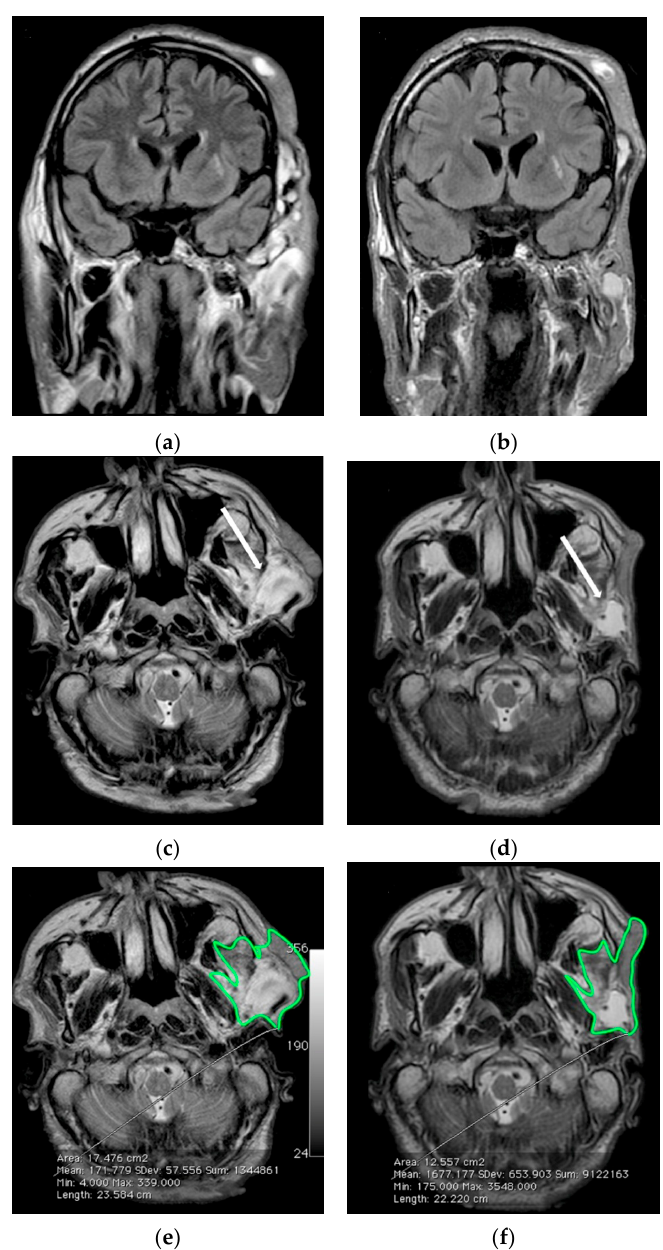
Figure 4. Serial MR imaging assessment of case 11. ( a ) Coronal FLAIR-weighted and ( c , e ) Axial TSE T2-weighted images of the left facial plexiform neurofibroma at baseline; ( b ) Coronal FLAIR-weighted and ( d , f ) Axial TSE T2-weighted images after six months of MedDietCurcumin. After six months there was a significant reduction especially in the hyperintense parts of the lesion, as indicated by arrows in ( c , d ). In ( e , f ) a green border contours the area used for volume measurement.